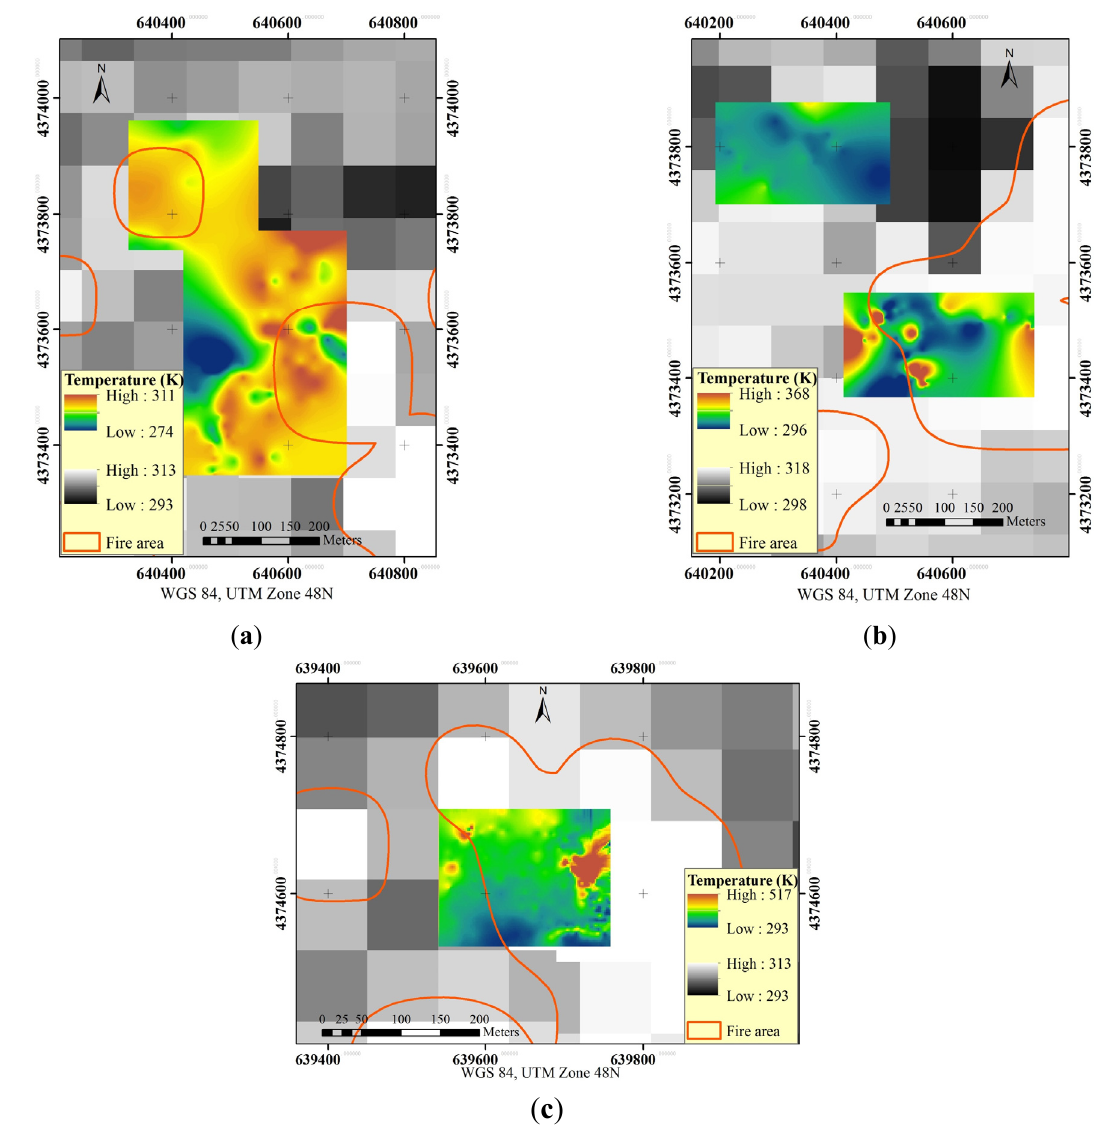
Figure 13. Coal fire polygons from SAGBT, overlaid on interpolated temperature measurements (color insets) for ( a ) 27 March 2013 and ( b ) 22 June 2013. A similar map ( c ) has SAGBT polygons for 27 March 2013 overlaid on interpolated measurements from 6 October 2013. ASTER TIR pixels are shown in